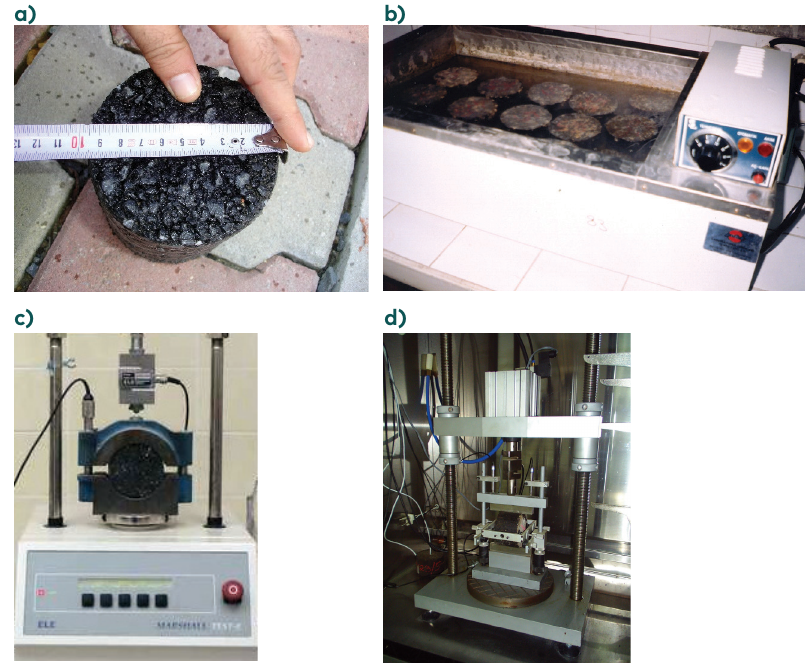
Figure 3. Experimental procedures for core samples: a) core sample diameter measurement, b) sample curing pool, c) Marshall test and,